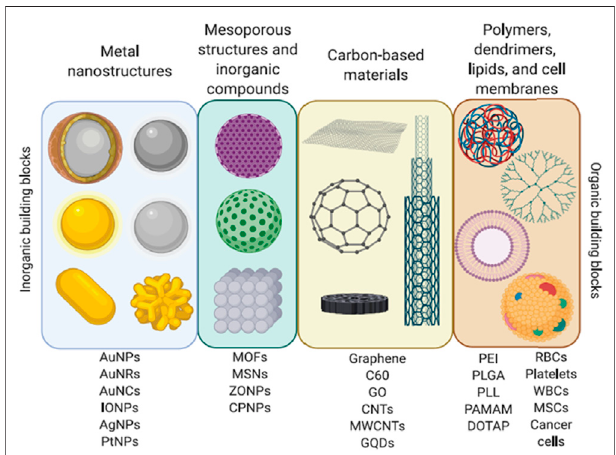
FIGURE3| Nanomaterials.Diverseorganicandinorganicnanomaterials are used to construct nanosystems for biomedical applications. Adapted with permission from Seaberg J, Montazerian H, Hossen MN, Bhattacharya R, Khademhosseini A, Mukherjee P. Hybrid Nanosystems for